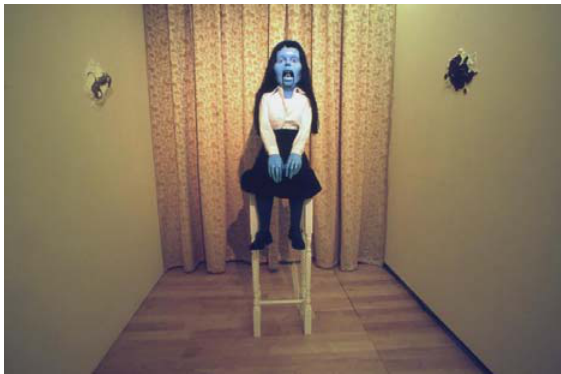
Figure 5. Candy Cannibal at The Lowry. Source: the artist and Matt’s Gallery, London, UK.